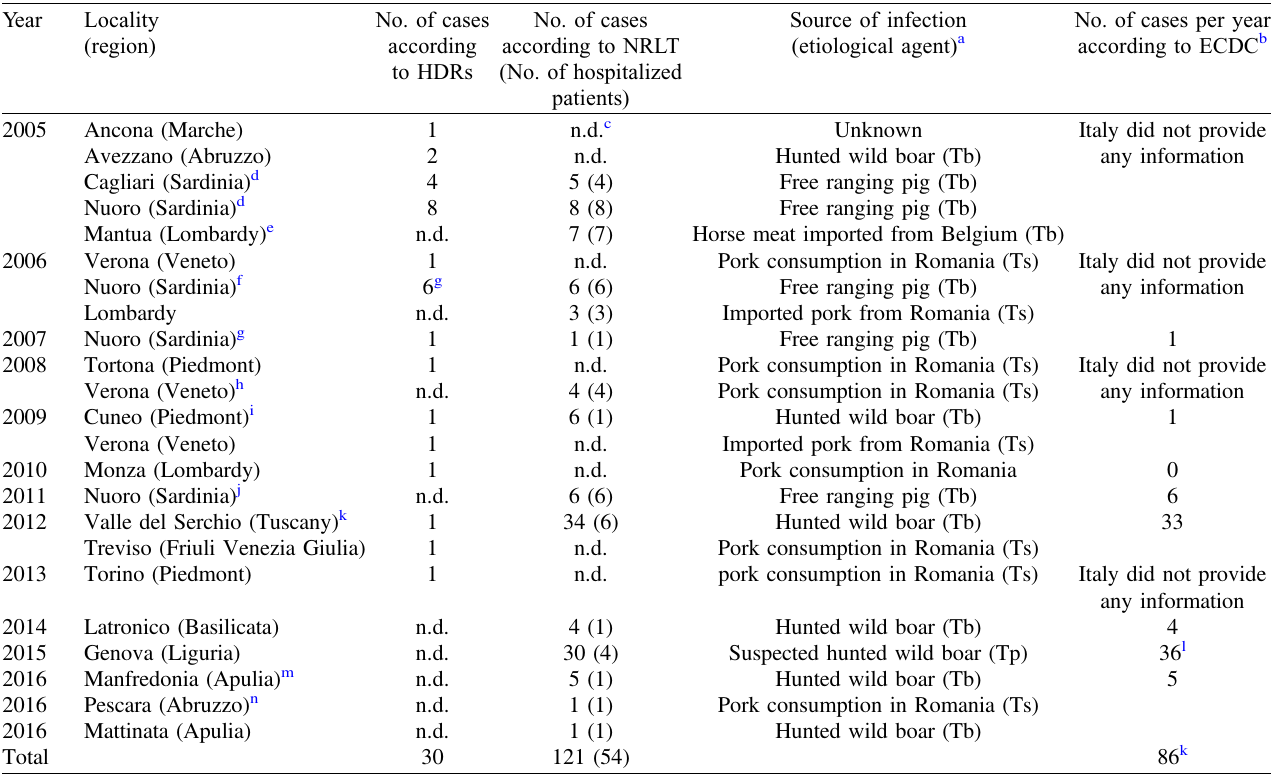
Table 2. Human trichinellosis cases documented in Italy from 2005 to 2016 according to hospital discharge records (HDRs), surveillance by the National Reference Laboratory for Trichinella (NRLT), and ECDC